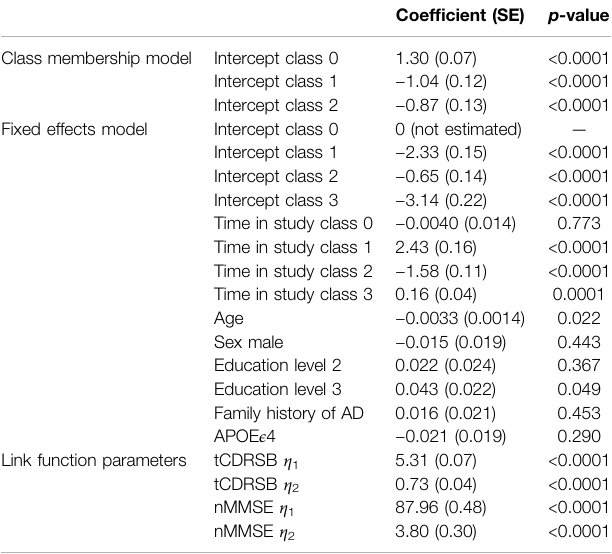
TABLE 2 | Results of the 4-class MLCMM on the 1,543